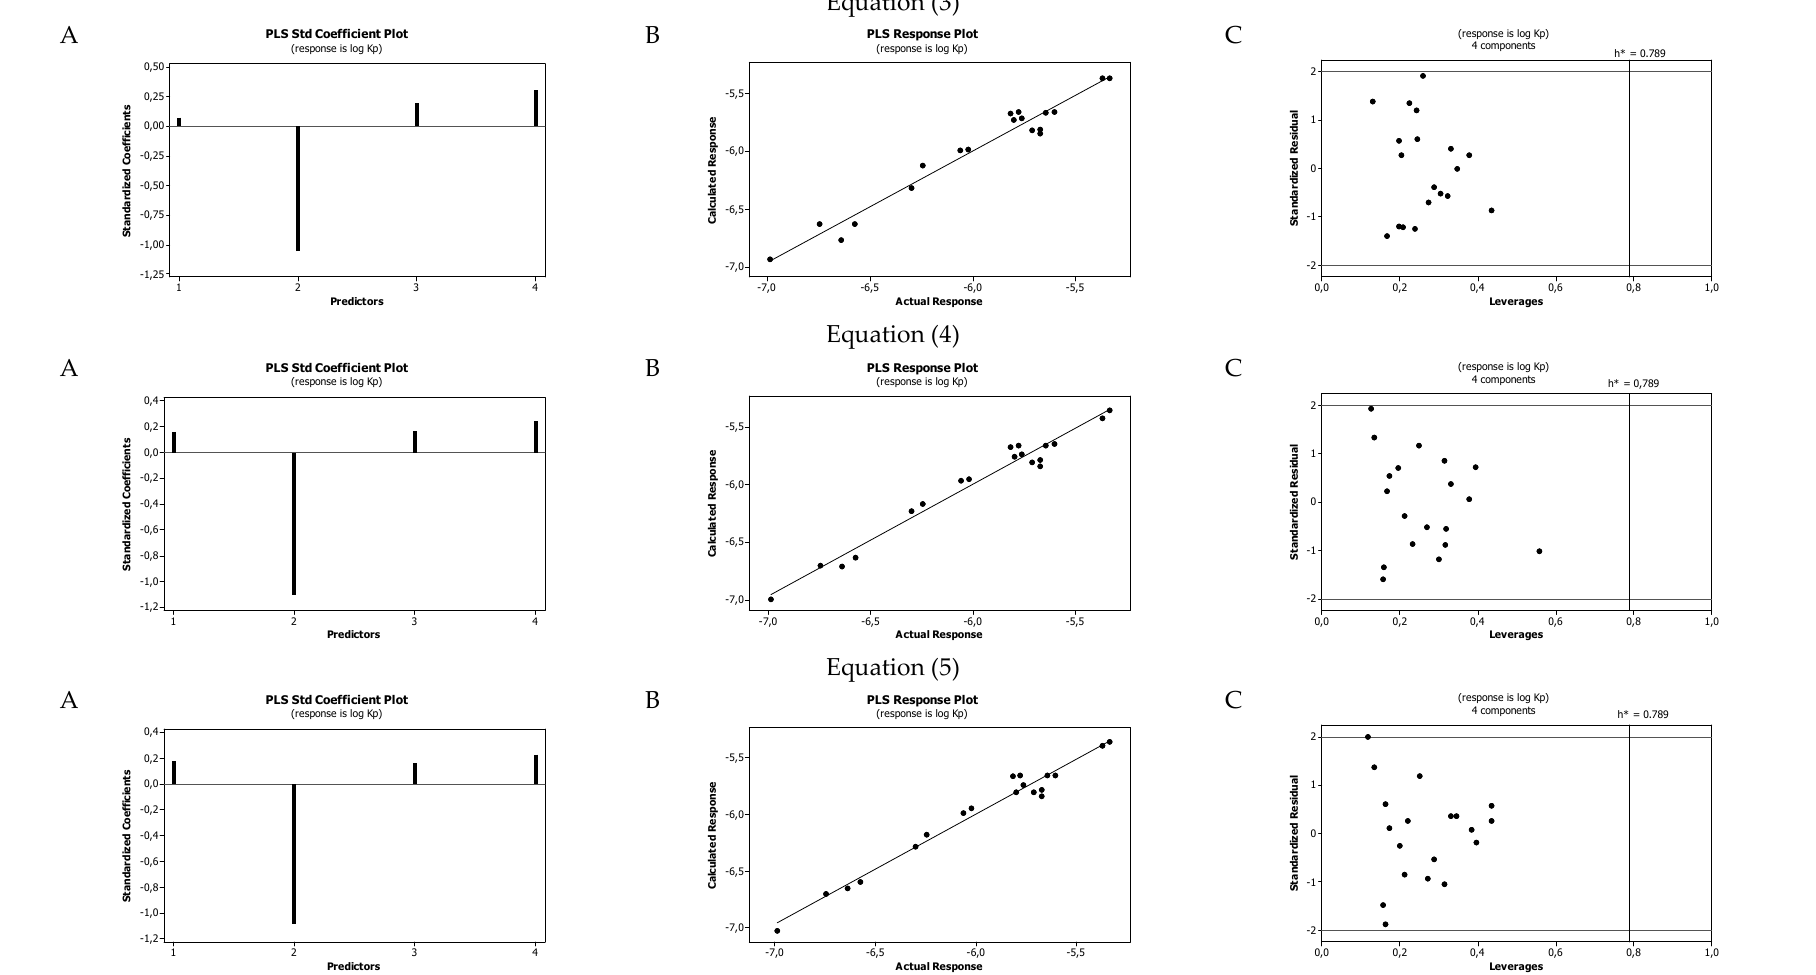
Figure 1. Standardized coefficients ( A ), the correlation between actual (ACD/Percepta) and predicted (Equations (3)–(5)) log K p parameters ( B ), and the Williams plots of Equations (3)–(5) ( C ).